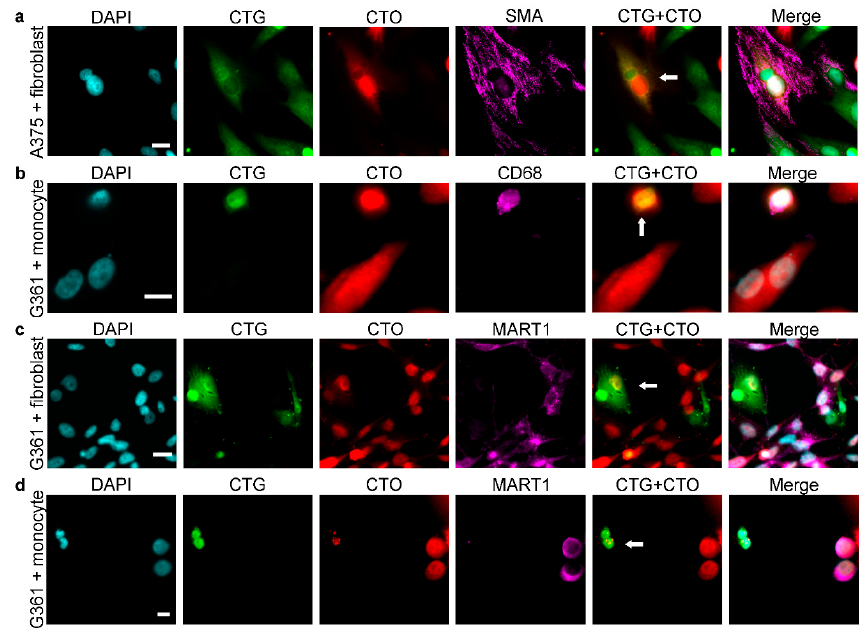
Figure 5. Melanoma–fibroblast and melanoma–monocyte hybrids are indistinguishable from stromal cells based on immunophenotype. ( a ) A melanoma (CTO)–fibroblast (CTG) hybrid cell expressing the fibroblast marker smooth muscle actin (SMA). ( b ) A melanoma (CTO)–monocyte (CTG) hybrid expressing the monocyte-macrophage marker CD68. ( c , d ) A melanoma (CTO)–fibroblast (CTG) hybrid ( c ) and a melanoma (CTO)–monocyte (CTG) hybrid ( d ), which do not express the MART1 melanoma marker. White arrows indicate hybrid cells. White bars indicate 20 µ m in the case of fibroblasts ( a , c ) and 10 µ m in the case of monocytes ( b , d